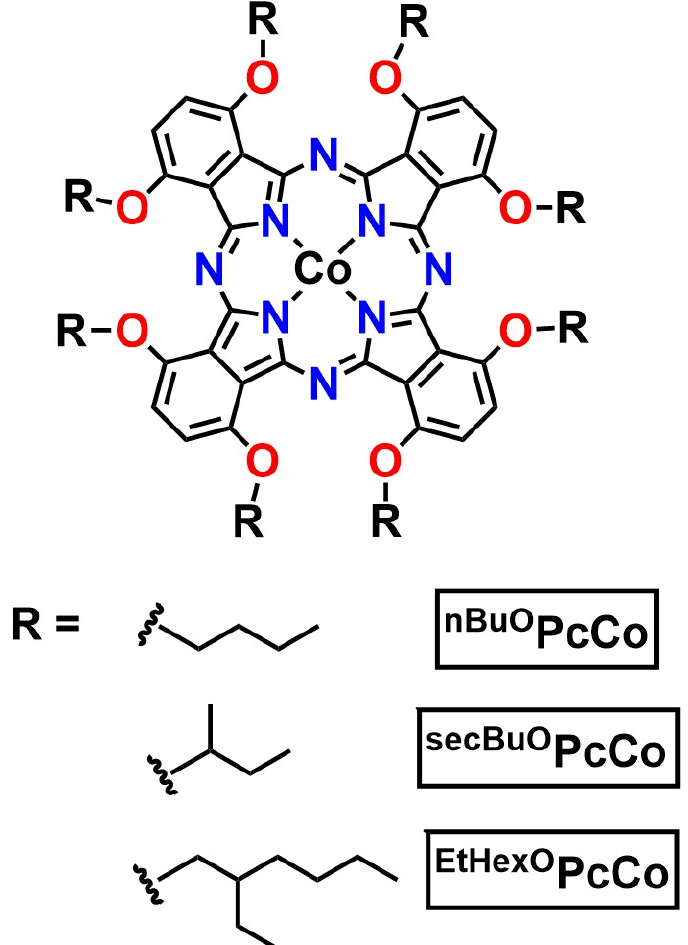
Figure 1 . Structures of 1,4,8,11,15,18,22,25-octaalkoxyphthalocyanine cobalt(II) ( RO PcCo) electrocatalysts (R = n-butyl, sec-butyl, and 2-ethylhexyl).